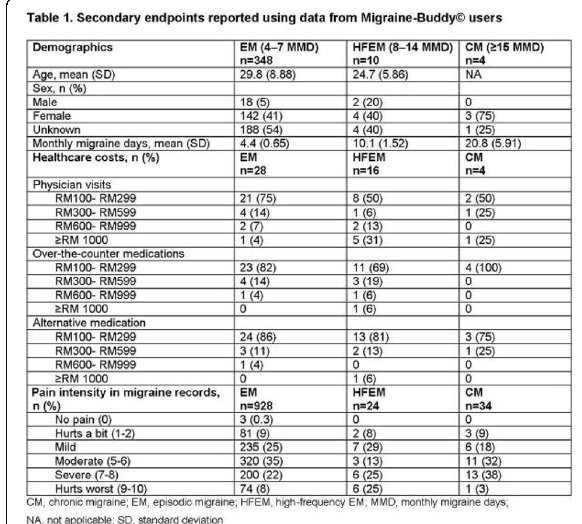
Table 1 (abstract P0220). See text for description